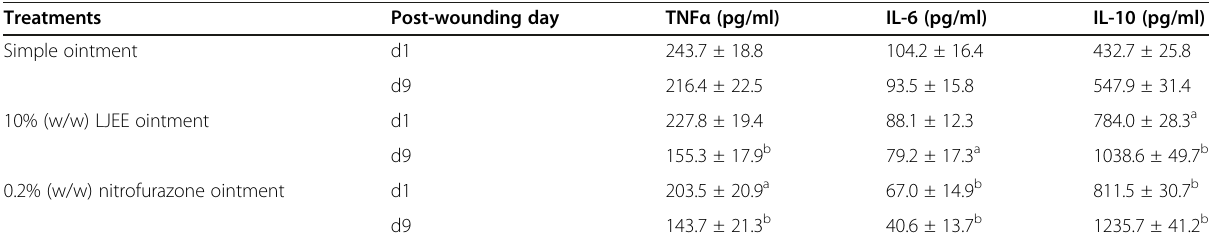
Table 1 Effects of LJEE ointment on the production of TNF α , IL-6, and IL-10 in healed wounds on days 1 (d1) and 9 (d9) after wounding